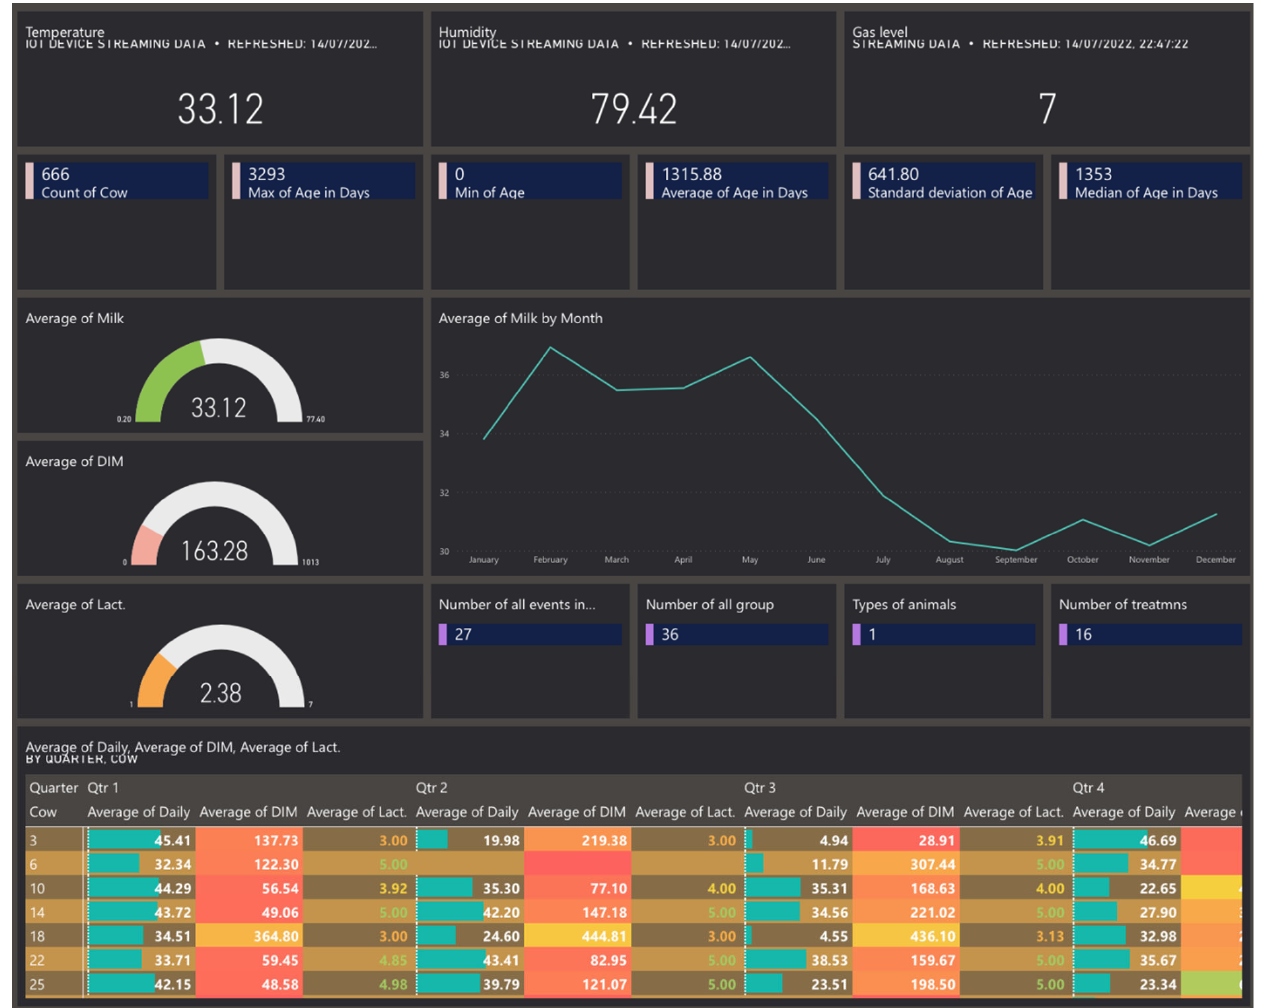
Figure 17. Smart Livestock monitoring system—Dynamic Dashboard. The data table uses “heat rules” that are restricted to two colors and a gradient in-between. Values above the column average have a green background. Values below column average have a red background. Values close to column average have a gradient background.